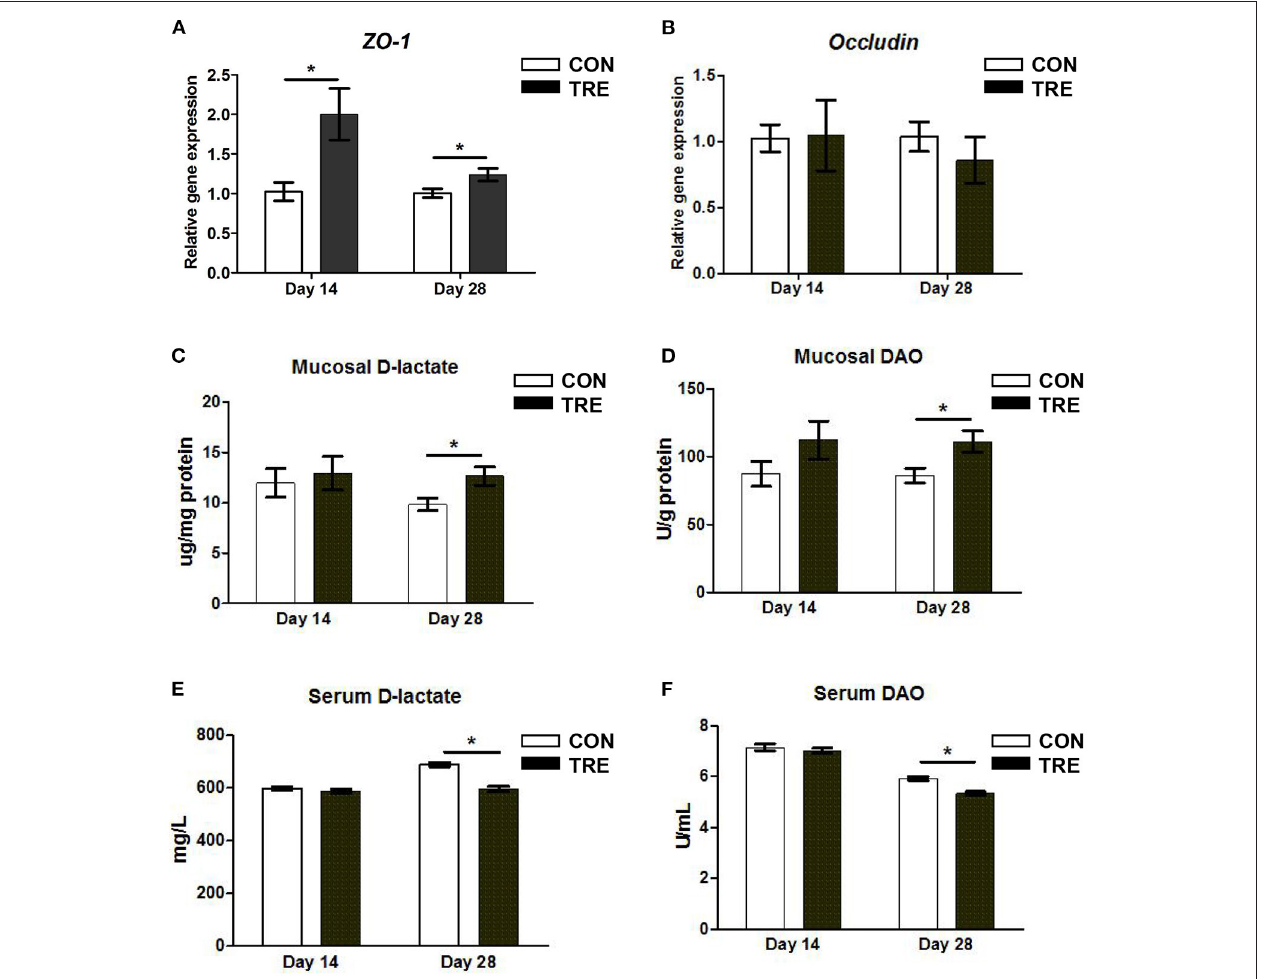
FIGURE 2 | Effect of protein restriction and succedent realimentation on the barrier function of jejunum in weaned piglets ( n = 6). (A) Alterations of zonula occludens 1 ( ZO-1) genes expression in jejunal mucosa on day 14 and 28. and (B) Alterations of occludin genes expression in jejunal mucosa on day 14 and 28. (C) Alterations of D-lactate levels in jejunal mucosa on day 14 and 28. (D) Alterations of diamine oxidase (DAO) level in jejunal mucosa on day 14 and 28. (E) Alterations of D-lactate level in serum. (F) Alterations of diamine oxidase (DAO) level in serum. P < 0.05 were considered significant and markers (*) between groups on the same day. CON, control group; TRE, treatment